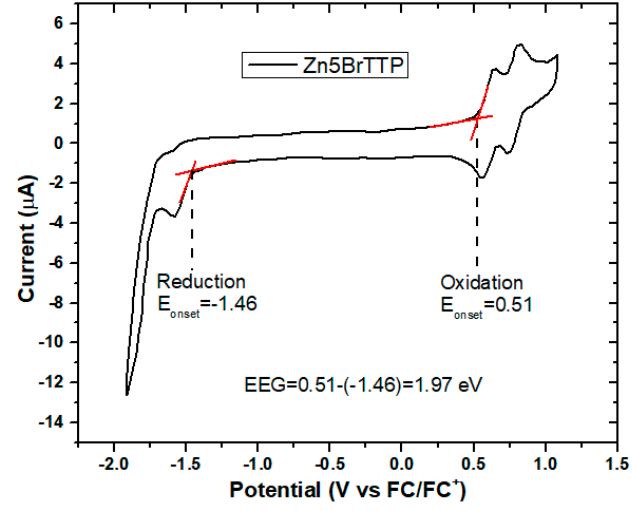
Figure 2. Voltammogram of ZnBrTTP using graphite as working electrode and Ag/AgCl counter electrode and Pt wire as a counter electrode. Information adapted from [76].